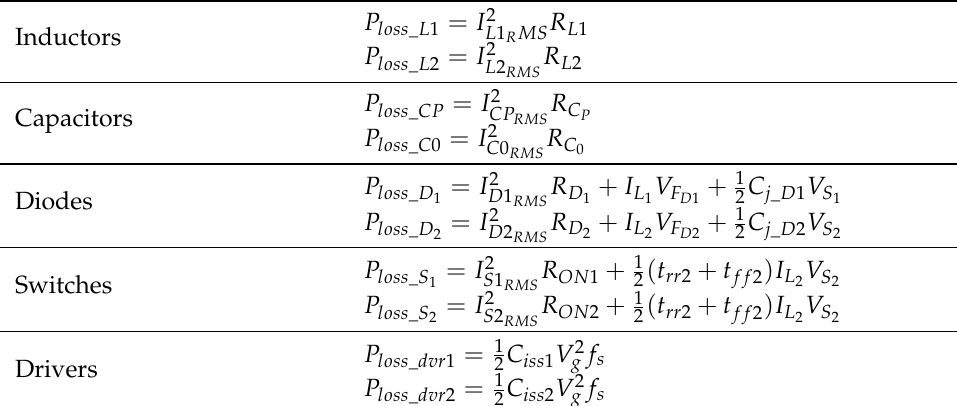
Table 2. Power losses